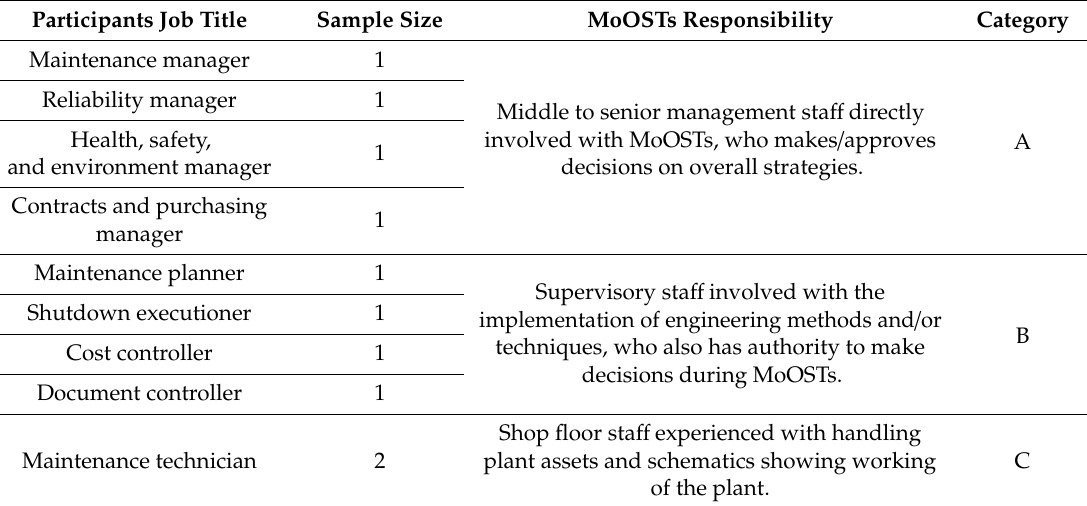
Table A10. Group decision participants profiles and